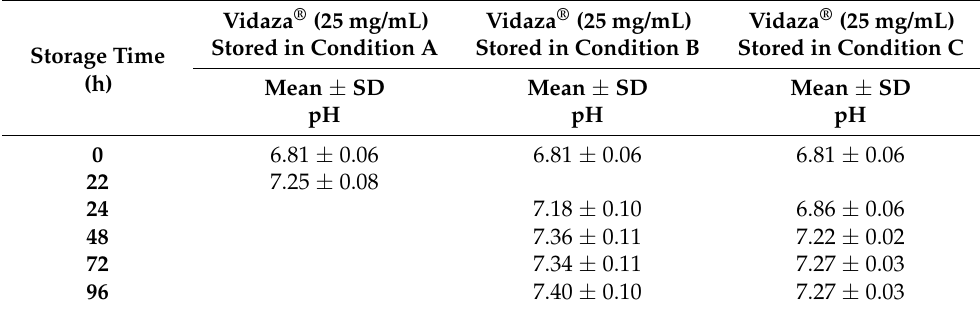
Table 2. pH of Vidaza ® (25 mg/mL) stored at 2–8 ◦ C in the original container (condition A), in a polypropylene syringe (condition B), and in a polypropylene syringe placed between two refrigerant gel packs (condition